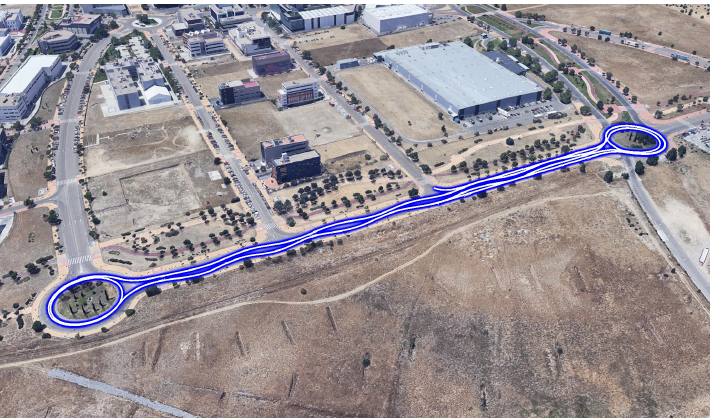
Figure 11. Experimental scenario for the validation